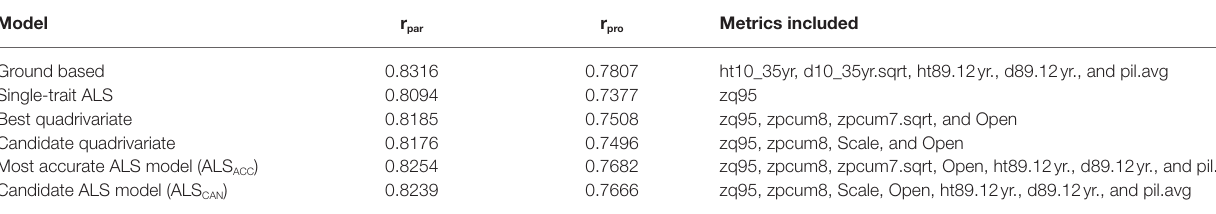
TABLE 4 | Summary of parental (r par ) and progeny (r pro ) mean breeding value accuracies for different models.